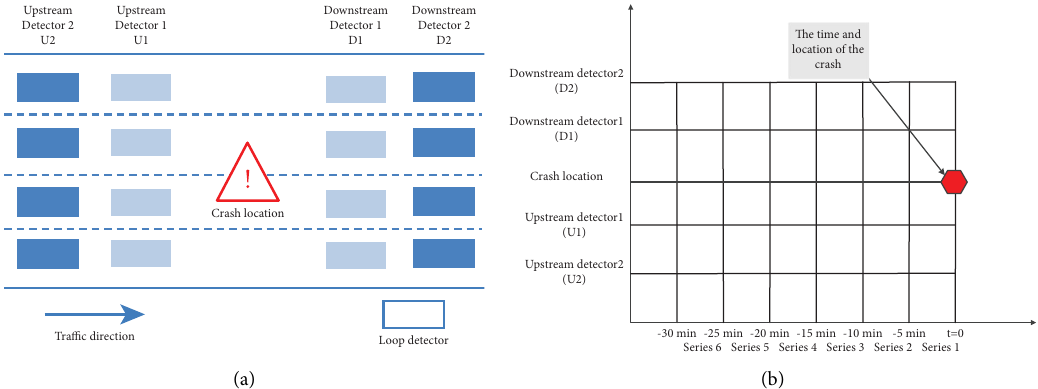
Figure 1: Schematic diagram of sample data extraction based on temporal and spatial features. (a) Spatial feature. (b) Temporal